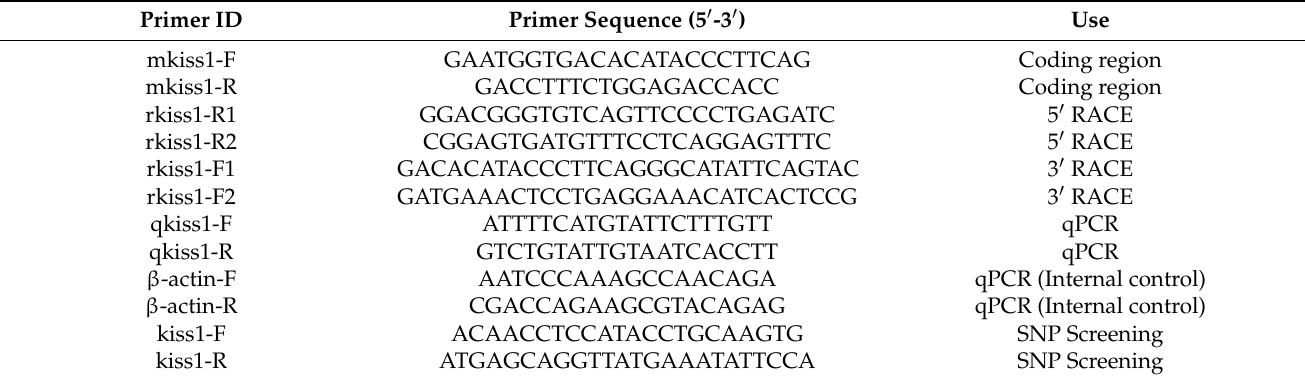
Table 1. Primer sequences for amplification of the kiss1